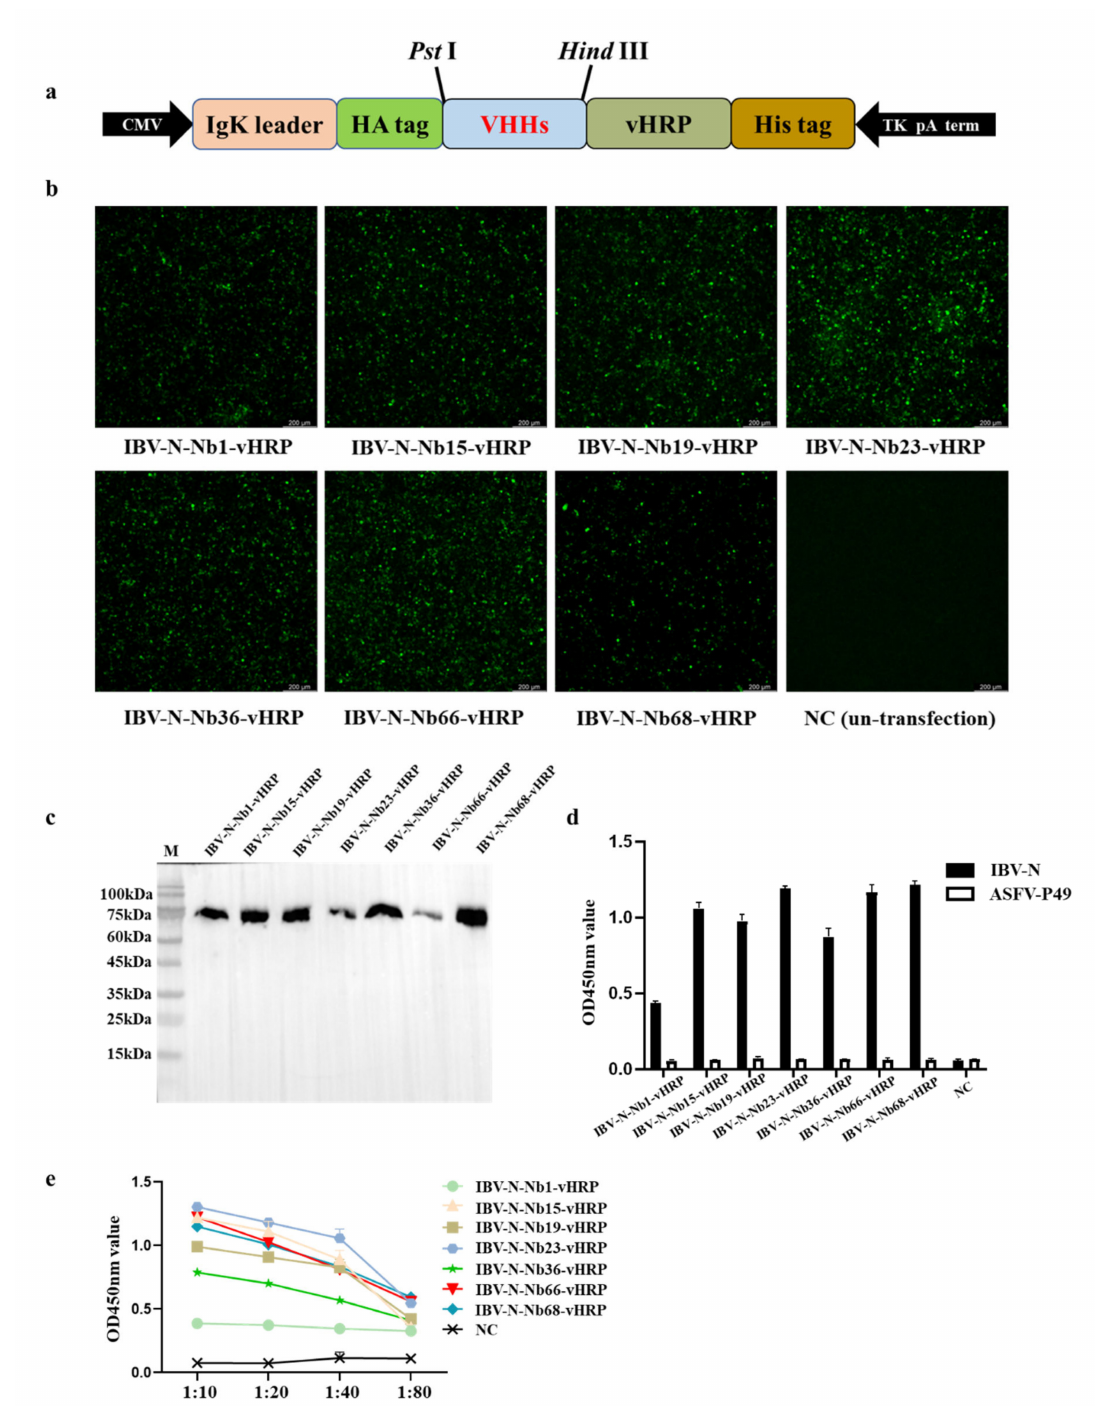
Figure 4. Expression and characterization of the 7 RANbodies against IBV-N protein in the HEK293T cells. ( a ) Schematic representation of the expression vector pCMV-VHHs-vHRP for RANbodies. ( b ) Identification of RANbodies against IBV-N protein expressed in the HEK293T cells by IFA (transfection for 48 h). ( c ) Western blot analysis of the 7 RANbodies against IBV-N protein secreted into the medium of HEK293T cells (transfection for 72 h). ( d ) Analysis of the 7 RANbodies specifically binding with the IBV-N protein with direct ELISA (transfection for 72 h), and the ASFV-P49 protein was treated as negative control. ( e ) Titers of the 7 RANbodies in the medium of HEK293T cells by direct ELISA detection. Note: the experiment of ELISA was repeated three times, and three repeat holes were performed for each